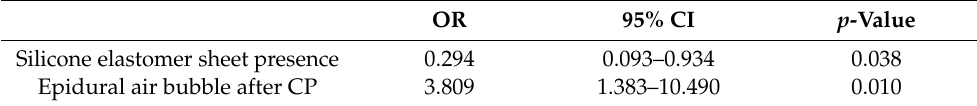
Table 5. Multivariate regression analysis for risk factors of epidural fluid